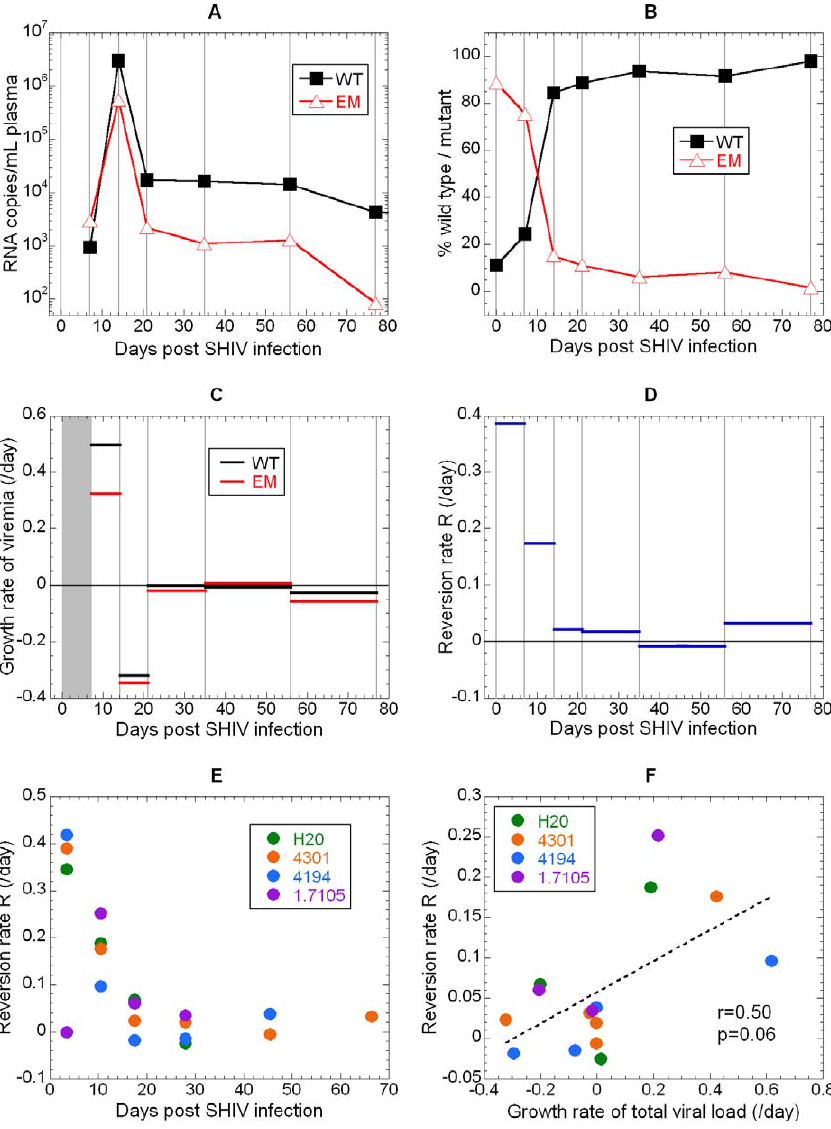
Figure 4. Rapid Early Reversion of KP9 from Escape Mutant to Wild-Type Virus The levels of WT and EM virus in a representative animal (#4301) are shown (A), as is the fraction of EM and WT virus over time (B). The average growth rates of WT (black) and EM (red) virus in different time intervals are calculated from the viral loads in (C), and the rate of reversion to WT is shown in (D). Growth rates could not be evaluated during the first week because the viral loads at day 0 were below detection (grey rectangle in [C]), but reversion rate was calculated from the known percentages of EM and WT in the inoculum. A comparison of the variation of reversion rate with time is shown for the different animals (E), and the correlation between reversion rate and total virus growth rate (F).